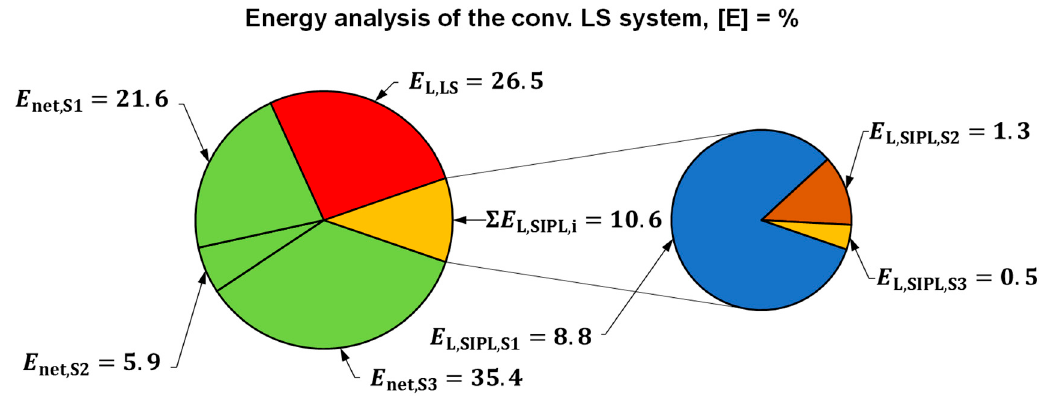
Figure 19. Energy analysis of the conventional LS system during the reference cycle. Previously published in [17]. Reproduced with permission from the publisher.